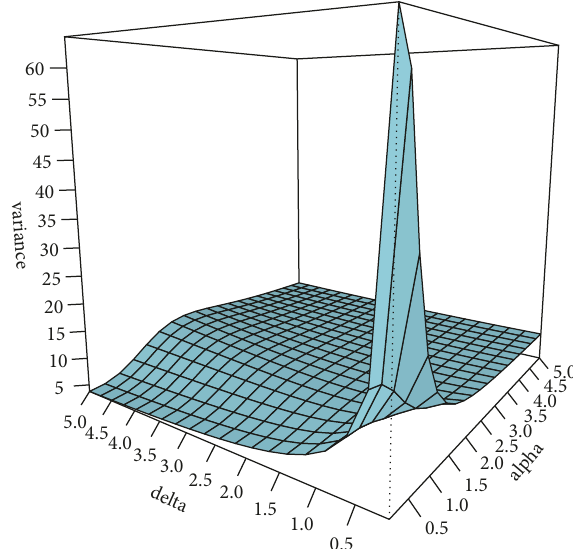
Figure 1: The variance function of the PMQL regression model at μ 2 . 50 for different values of α and δ (cid:29)